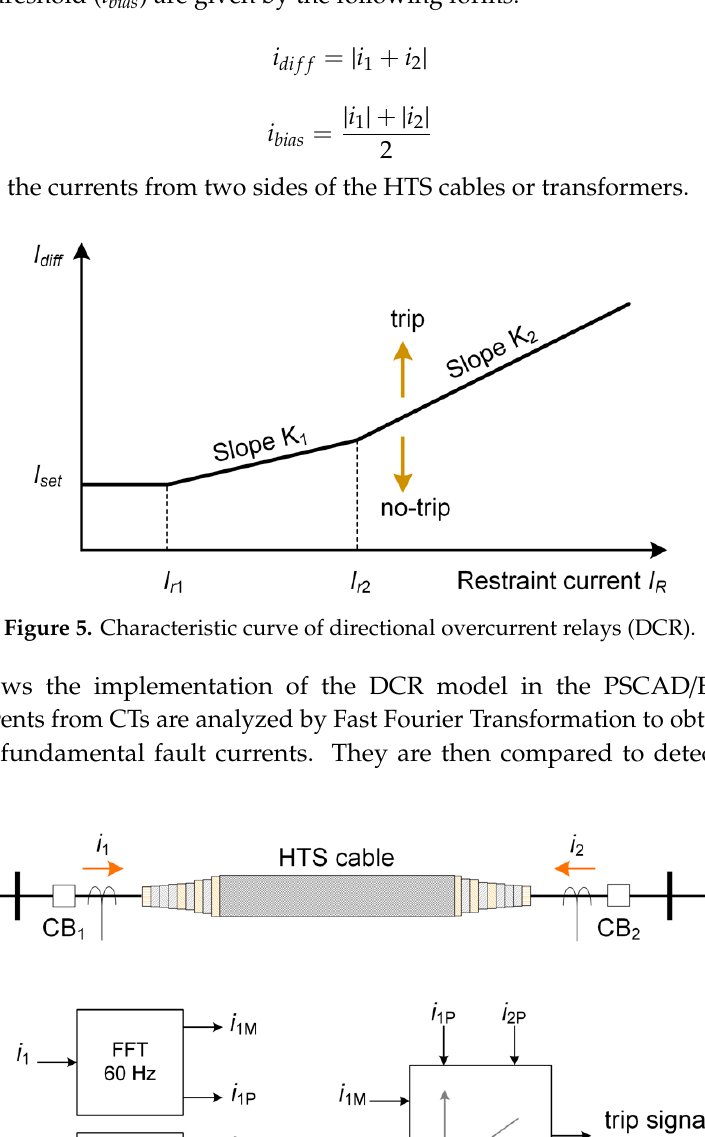
Figure 6. Implementation of DCR in PSCAD/EMTDC.